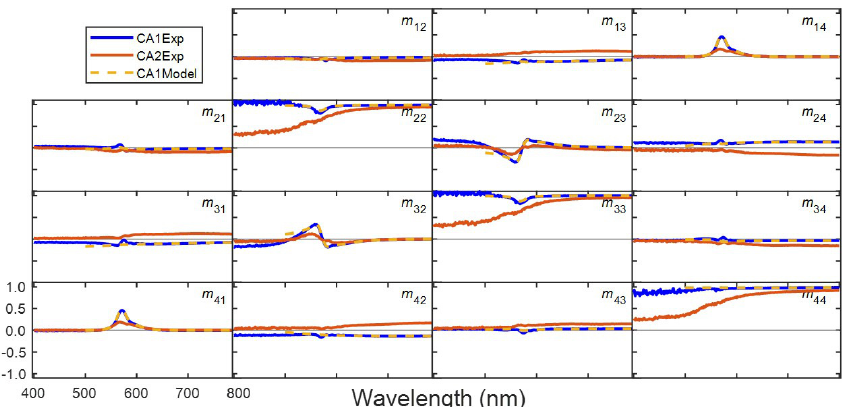
Figure 6. Transmission Mueller matrices of elytra from two specimens of C. aurata . The blue and red solid curves are data recorded on specimens with low (sample CA1) and high (sample CA2) depolarization, respectively. The yellow dashed curve is the best fit to data from CA1 using regression analysis in a bianisotropic model (method III).